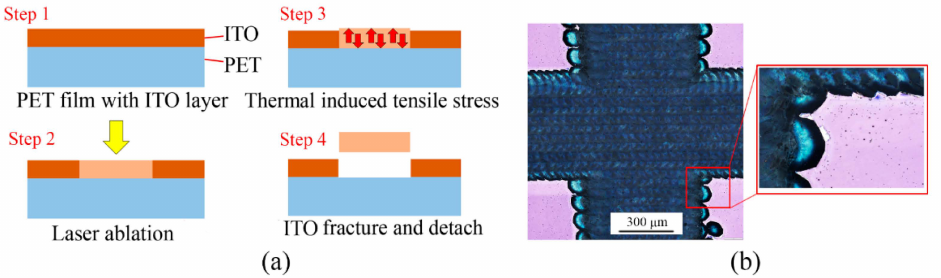
Figure 2. Laser ablation process on the ITO-covered PET substrate. ( a ): Laser fabrication process for patterning the ITO electrodes on PET substrate. ( b ): Optical microscope image of the laser-ablated areas on the PET substrate.